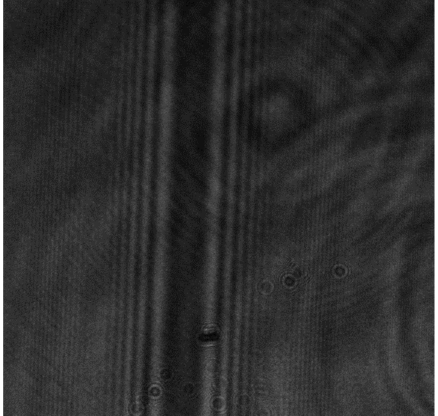
Figure 13. Diffraction pattern on the CCD of a hair.